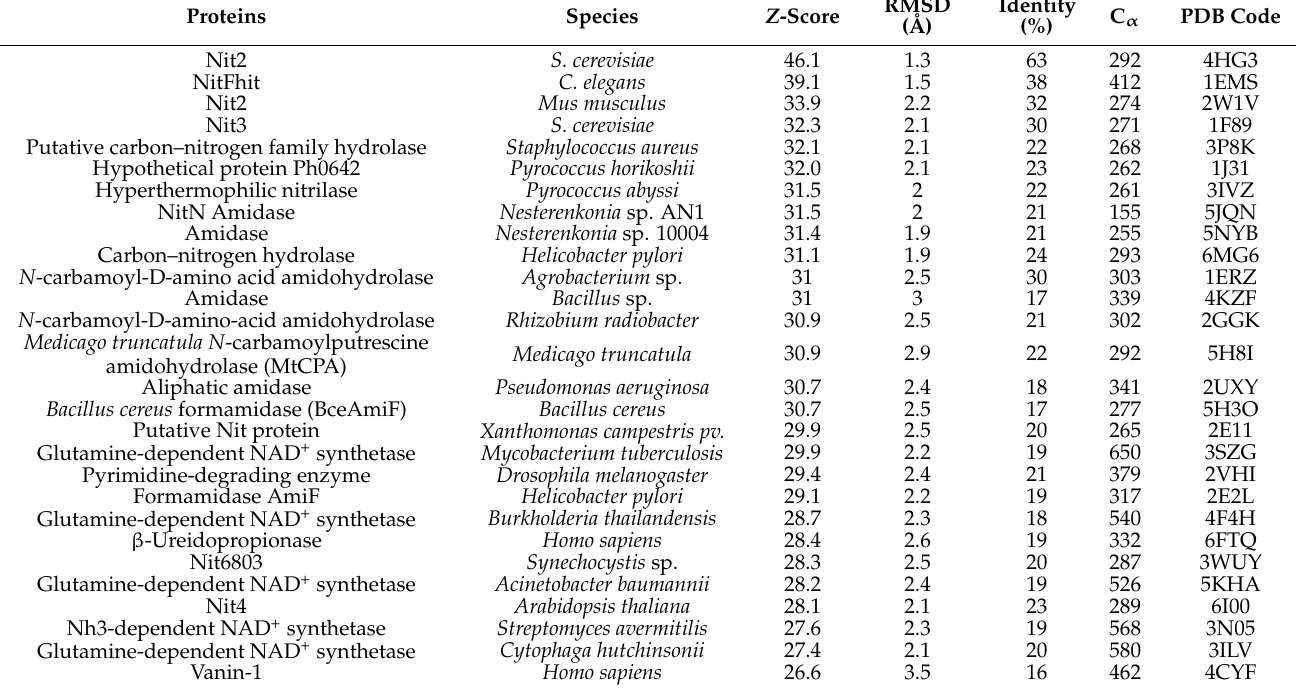
Table 2. Structural similarity comparison of homologous structures using Dali 1